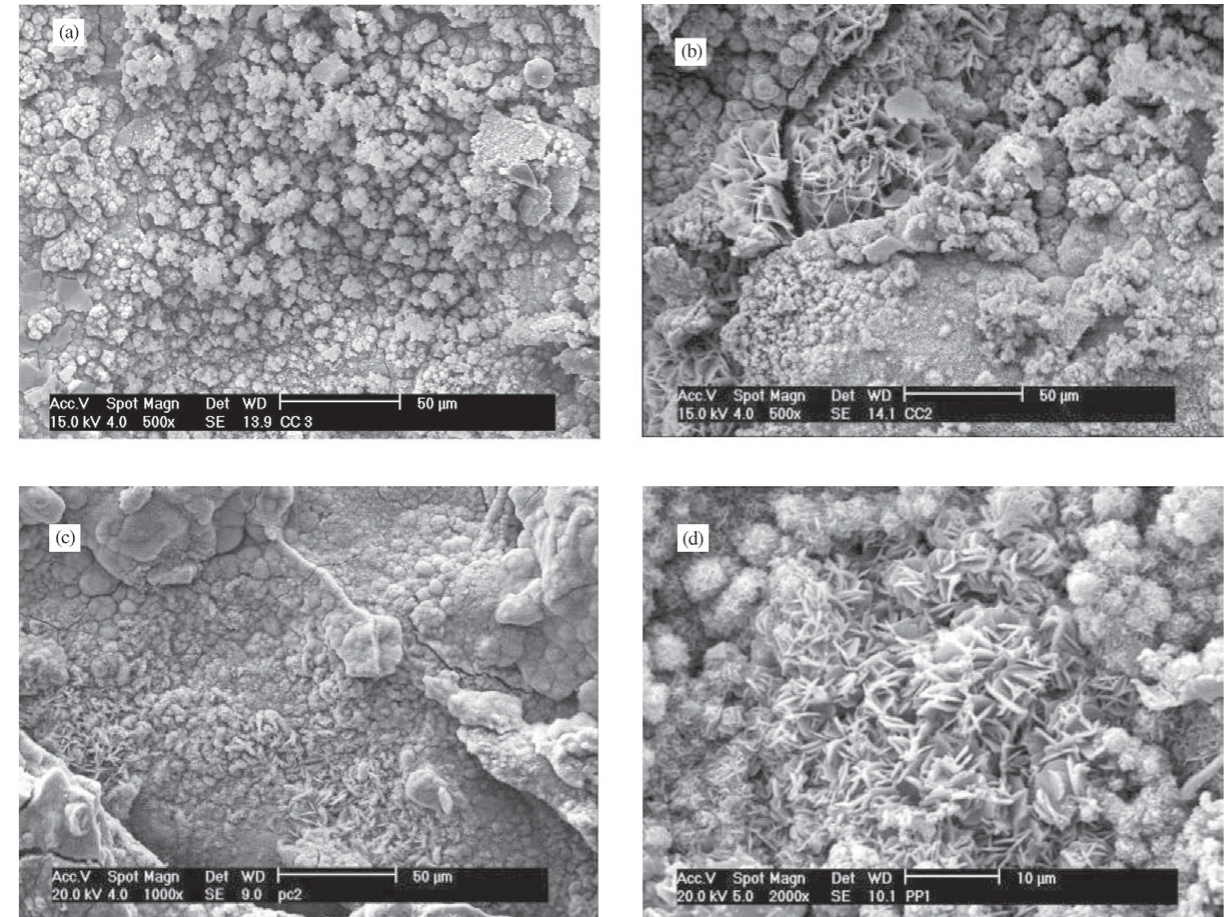
Figure 5. Micrographs showing: a) sandy crystals (lepidocrocite); b) irregular and not protective oxide layer formed on carbon steel specimen exposed at Cubatão ; c) compact oxide layer on carbon steel specimen exposed at Paula Souza and d) flowery structures (centre of photo), typical of lepidocrocite on weathering steel